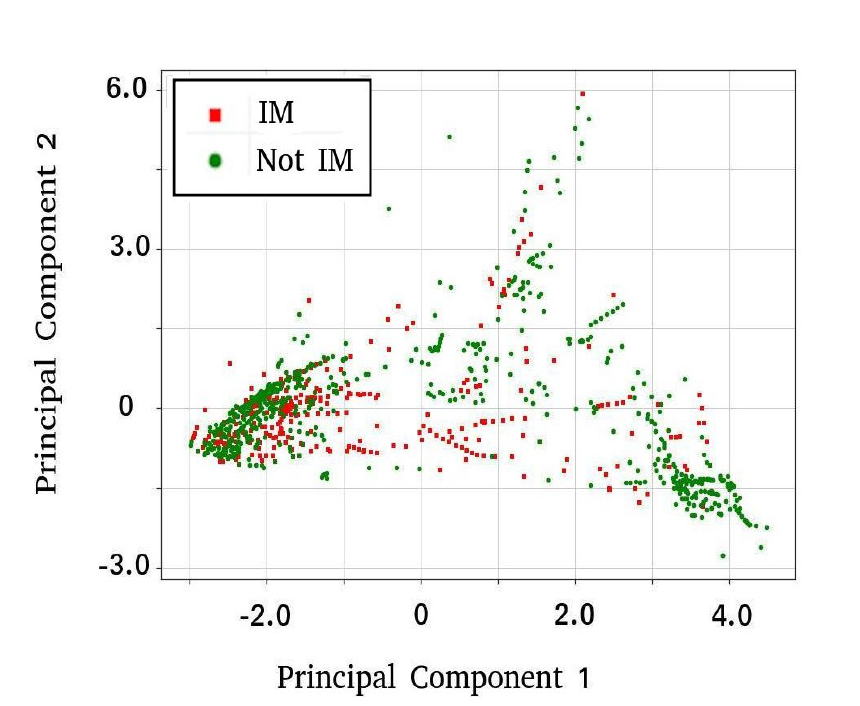
Figure 3. The dataset distribution of the IM and Not IM labels has been visualized using the two principal components (PC 1 and PC 2). The alloys consisting of intermetallic phase at full or partial proportion (IM) are represented by red-colored points, whereas the alloys devoid of intermetallic phase (Not IM) are shown as green-colored